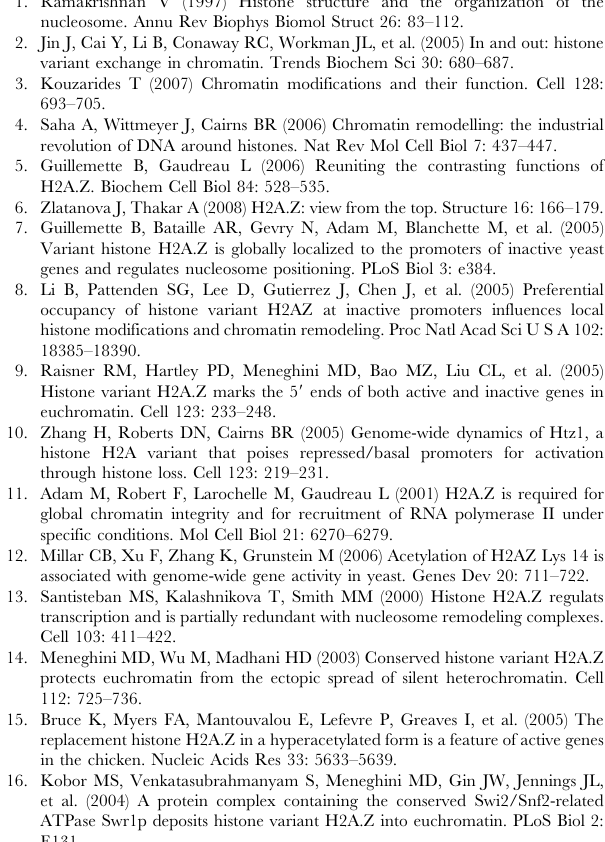
Table S1 Transcription profiles of htz1 D relative to swr1 D , swc2 D and swc5 D . DOC) Table S2 Differentially expressed genes in htz1, swr1, swc2, swc5 and double mutants relative to wild type. Table S3 Strains. DOC) Table S4